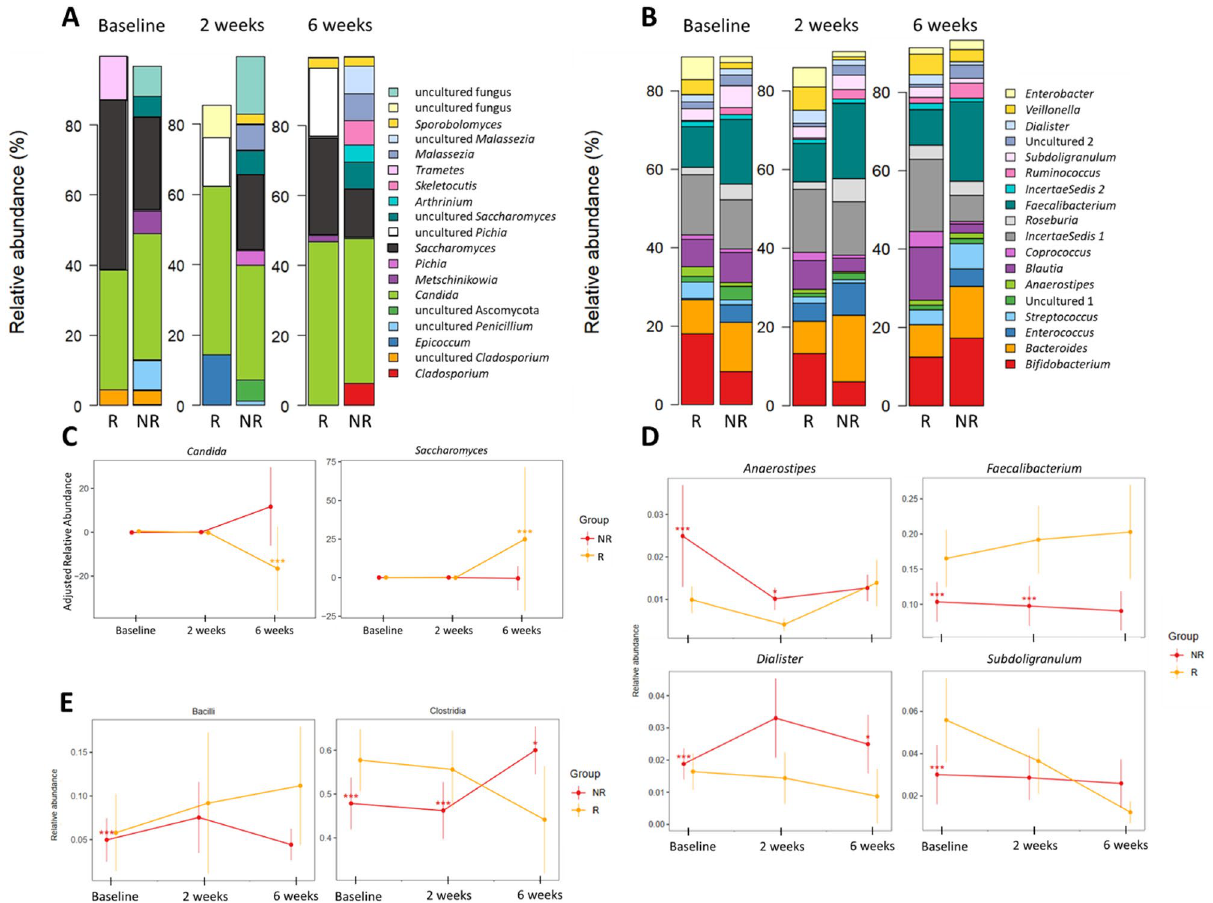
Figure 2. Overview of the fecal ( A ) fungal mycobiota and ( B ) bacterial microbiota composition before start of infliximab (IFX) therapy (baseline), two weeks and six weeks after treatment stratified by response to induction therapy to IFX. The plots present the most abundant genera, which are color-coded and shown on the right-side panel. ( C ) The standardized confounder-adjusted relative abundance of the fungal genera that significantly differed between response groups presented throughout the study and ( D ) the relative abundance of the bacterial genera and ( E ) classes that differed significantly at baseline between response groups presented throughout the study. R presents responders and NR presents non-responders. (*p